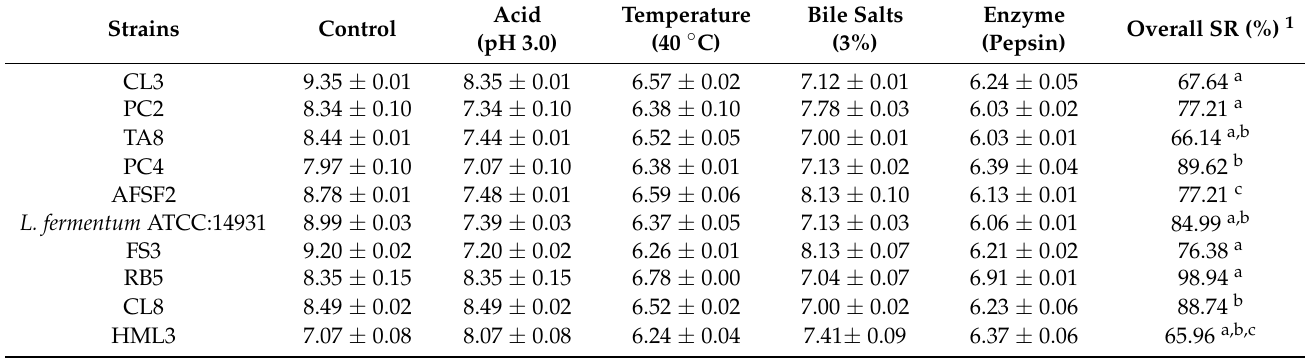
Table 1. The survivability rates of 10 strains after 6 h of exposure at different parameters against Lactobacillus fermentum